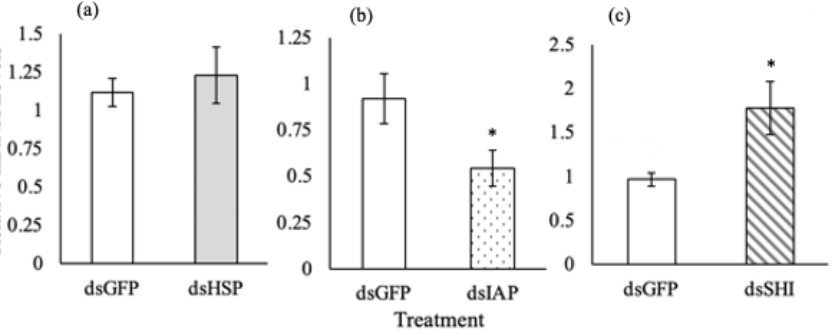
Figure 1. Relative mRNA levels of beetles treated with 10 µ g target dsRNAs compared to the dsGFP negative control. ( a ) The hsp gene showed no changes in relative mRNA levels, ( b ) iap showed a significant decrease, and ( c ) shi showed a significant increase (one-tailed t -test). * Indicates significant